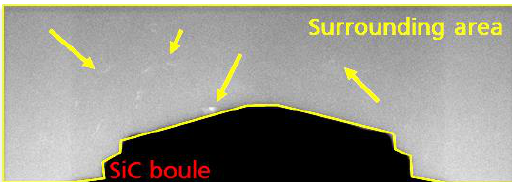
Figure 4. Definition of the di ff erent image areas a ff ected by the Bragg di ff raction patterns. The arrows in the surrounding area indicate the single peaks characterized by a higher intensity. Behind the SiC boule attenuation area (dark) the patters are also